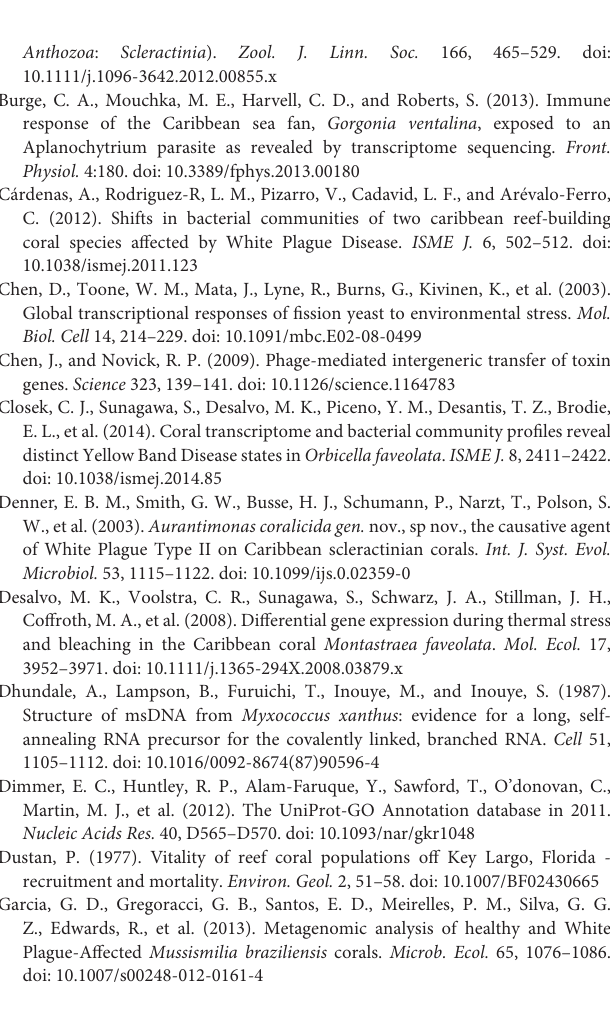
Avg_mRNA_abund_DD